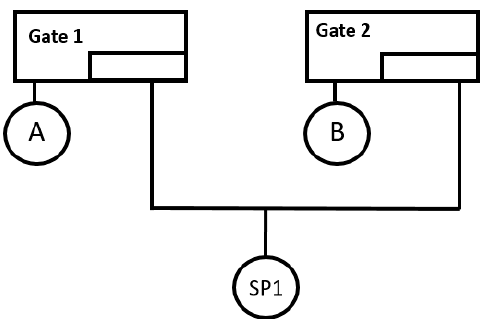
Figure 6. Sharing a component between SPARE gates.